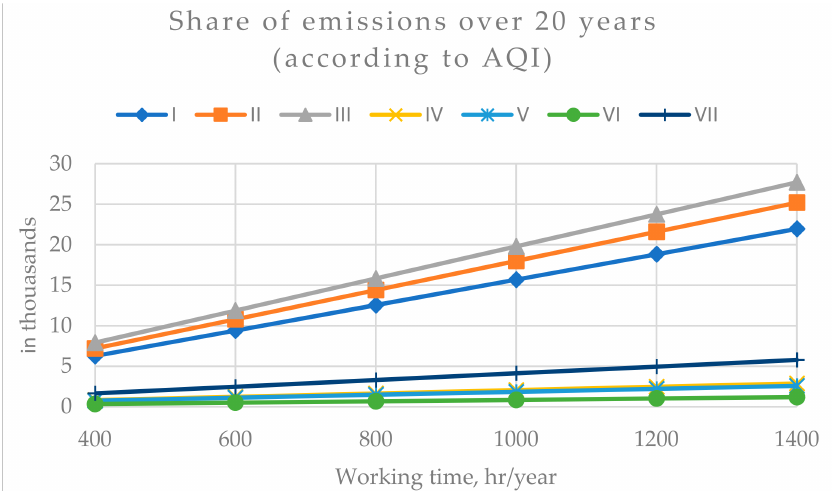
Figure 8. Global emission of the analyzed pollutants, taking into account the AQI shares for individual heating systems, for the installation operation time of 400 to 1400 h over 20 years of use, where: I—electric heating power supply, II—liquid heating supplied from the district heating network, III—liquid heating powered by a hard coal boiler, IV—liquid heating powered by a biomass boiler, V—liquid heating with fuel oil boiler, VI—liquid heating powered by a natural gas boiler, VII—liquid heating powered by a ground source heat